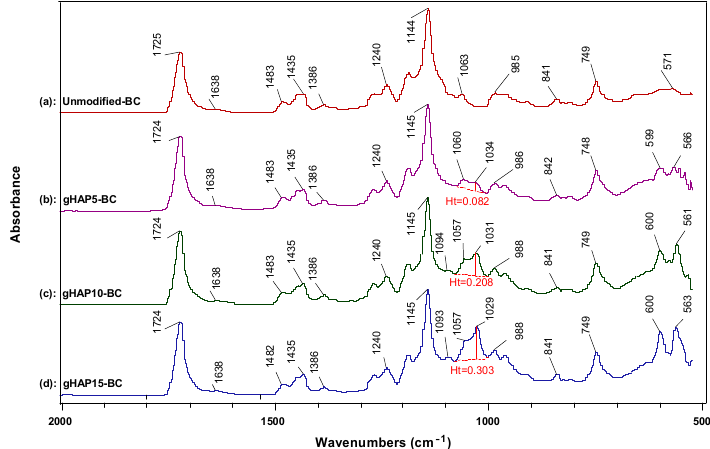
Figure 9. FTIR spectra of bone cement samples modified with 0, 5, 10, 15 wt.% loadings of gHAP, labeled as ( a ): unmodified-BC, ( b ): gHAP5-BC, ( c ): gHAP10-BC and ( d ): gHAP15-BC, respectively. (Note: all samples contained 5 wt.% of ZrO 2 ).